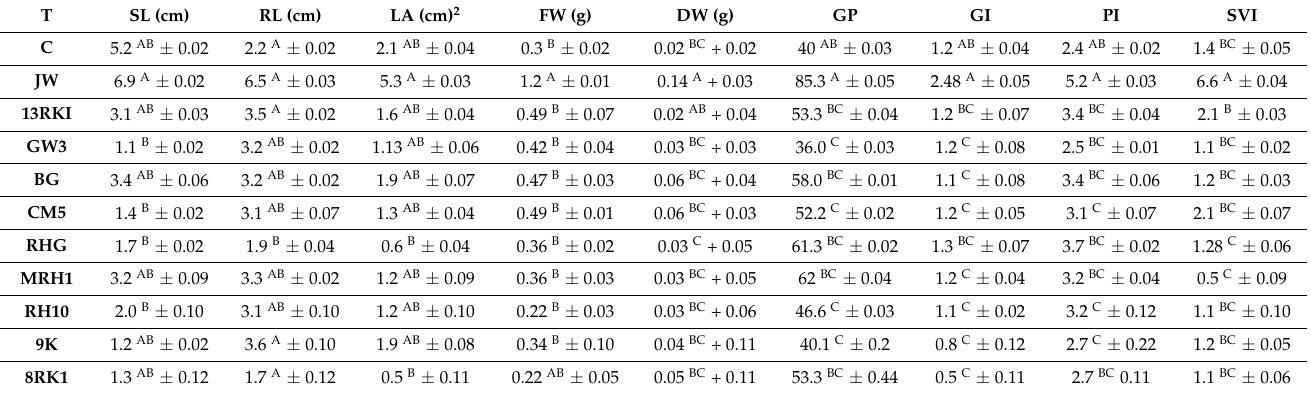
Table 1. Germination and biomass studies of Zea mays L. seedlings treated with PGPR.